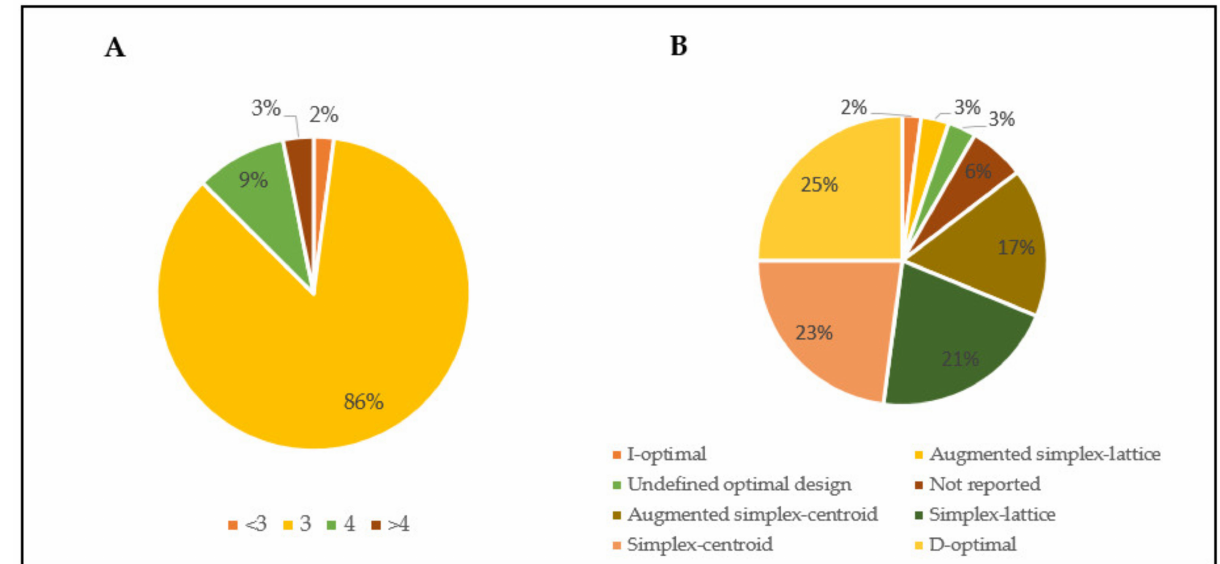
Figure 3. ( A ) Mixture complexity and ( B ) type of designs in the surveyed articles, respectively ( n =